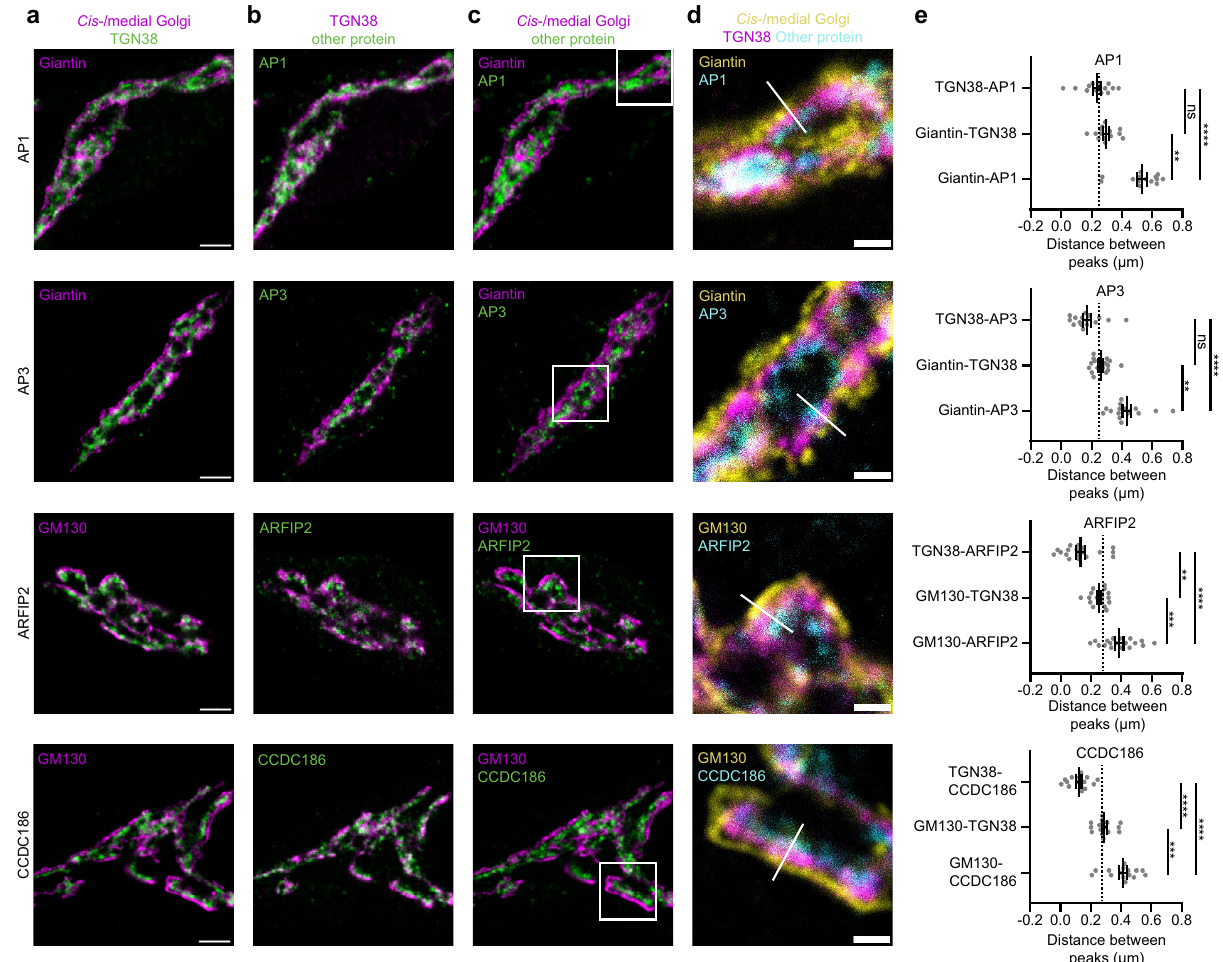
Figure 2. Several Golgi proteins localize downstream of TGN38. ( a – c ) Representative examples of neurons immunostained for a cis -/medial Golgi marker (GM130 or giantin), TGN38 and a protein of interest (AP1, AP3, ARFIP2 and CCDC186). Images showing immunostaining of cis -/medial Golgi marker and TGN ( a ), TGN and protein of interest ( b ), cis -/medial Golgi and protein of interest ( c ). ( d ) Zoom from the white square area marked in ( c ), showing all three stained proteins. White line is a representative example of a line drawn for intensity plotting. ( e ) Distance between intensity peaks of TGN38 and protein of interest, cis -/medial Golgi and TGN; and cis -/medial Golgi and protein of interest, measured by line scans. AP1: (TGN38-AP1: n = 14; Giantin- TGN38: n = 14; Giantin-AP1: n = 14). Kruskall-Wallis test with Dunn’s multiple comparisons test: TGN38-AP1 vs Giantin-TGN38: non-significant (ns), TGN38-AP1 vs Giantin-AP1: **** p < 0.0001, Giantin-TGN38 vs Giantin-AP1: ** p = 0.0036. AP3: (TGN38-AP3: n = 16; Giantin-TGN38: n = 16; Giantin-AP3: n = 16). Kruskall- Wallis test with Dunn’s multiple comparisons test: TGN38-AP3 vs Giantin-TGN38: non-significant (ns), TGN38-AP3 vs Giantin-AP3: **** p < 0.0001, Giantin-TGN38 vs Giantin-AP3: ** p = 0.0042. ARFIP2: (TGN38- ARFIP2: n = 18; GM130-TGN38: n = 18; GM130-ARFIP2: n = 18). One-way ANOVA with Tukey’s multiple comparisons test: TGN38-ARFIP2 vs GM130-TGN38: ** p = 0.0018, TGN38-ARFIP2 vs GM130-ARFIP2: **** p < 0.0001, GM130-TGN38 vs GM130-ARFIP2: *** p = 0.0009. CCDC186: (TGN38-CCDC186: n = 15; GM130-TGN38: n = 15; GM130-CCDC186: n = 15). One-way ANOVA with Tukey’s multiple comparisons test: TGN38-CCDC186 vs GM130-TGN38 and TGN38-CCDC186 vs GM130-CCDC186: **** p < 0.0001, GM130- TGN38 vs GM130-CCDC186: *** p = 0.0004. Dotted lines represent average distance between TGN38 and GM130 or TGN38 and giantin in the entire dataset. Bars show mean ± SEM. Detailed statistics are shown in Supplementary Table 1. Scale bar is 3 µm ( a ) and 1 µm ( d